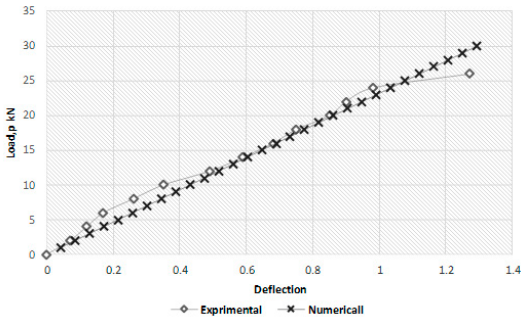
Figure 25. Load–deflection diagram of beam (B3).